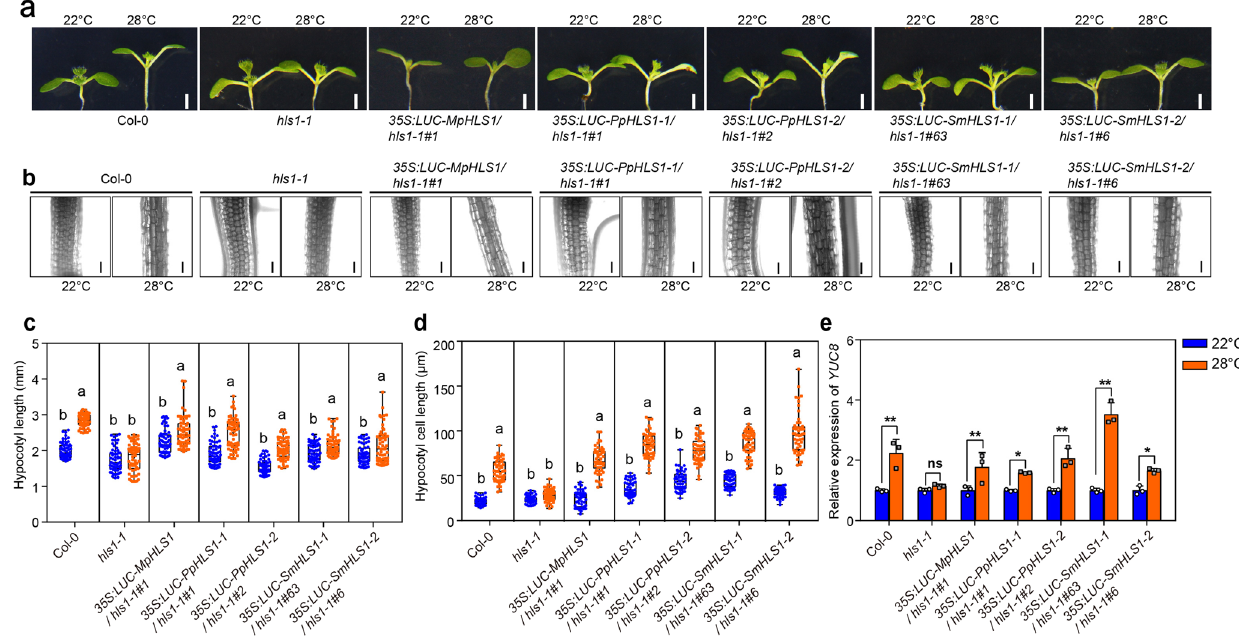
Fig. 6 Thermomorphogenesis phenotypes in complementation lines. a Representative images showing the hypocotyl phenotypes in seedlings grown under 22 °C or 28 °C. Scale bar = 1 mm. b Representative images showing the hypocotyl cells in the seedlings grown under 22 °C or 28 °C. Bars = 100 μ m. c Quanti fi cation of hypocotyl length. Signi fi cant differences were determined by two-way analysis of variance (ANOVA) and post hoc Tukey ’ s test, with different lowercase letters indicating signi fi cant differences (Data are means± SD; n = 60, P < 0.05). d Quanti fi cation of hypocotyl cell length. Signi fi cant differences were determined by two-way analysis of variance (ANOVA) and post hoc Tukey ’ s test, with different lowercase letters indicating signi fi cant differences (Data are means± SD; n = 50, P < 0.05). e Expression levels of YUC8 in the seedlings grown under 22 °C or 28 °C. Signi fi cant differences were determined by two-way analysis of variance (ANOVA) and post hoc Tukey ’ s test (Data are means ± SD; n = 3, * P < 0.05, ** P < 0.01).